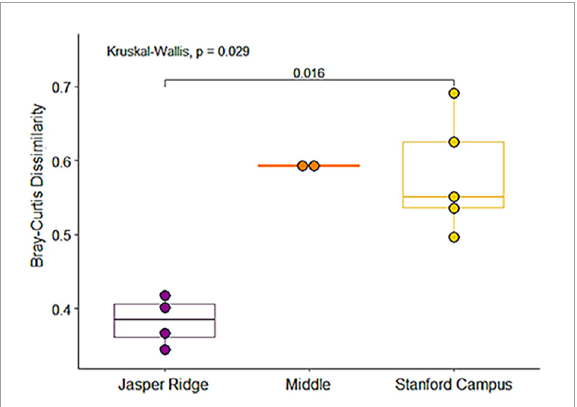
FIGURE4 Boxplot of Bray-Curtis dissimilarities between Anthropocene collection sites and their corresponding Holocene archeological site by study area. Pairwise significance based on a Wilcoxon